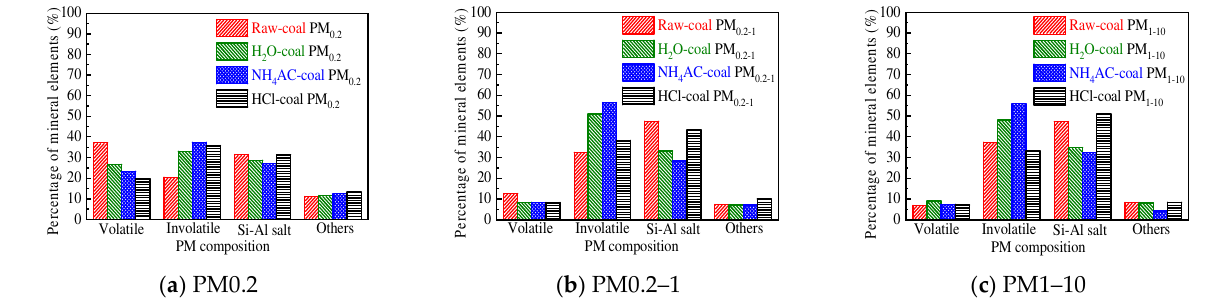
Figure 7. Composition of various size fractions of coal ash generated from CFA-treated coal samples. Volatile denotes Na, K, and S; Non-volatile denotes Mg, Ca, and Fe.